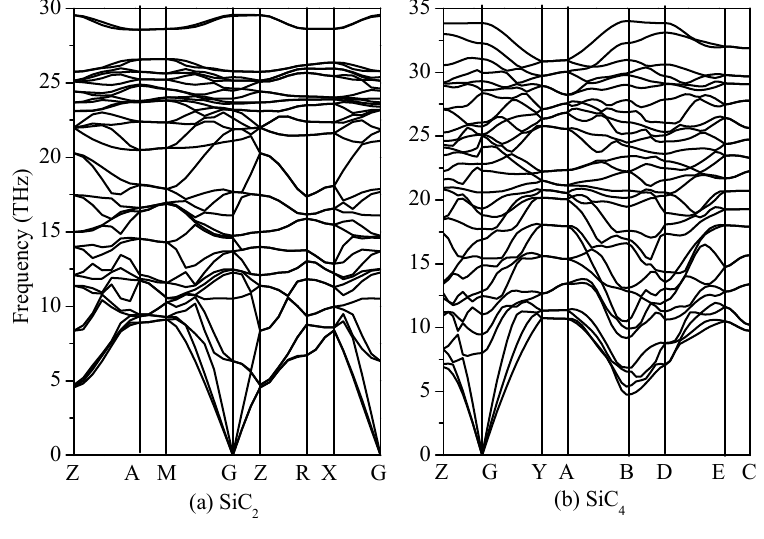
Figure 3. Phonon spectra for SiC 2 ( a ) and SiC 4 ( b ). Table 1. The calculated lattice parameters and elastic moduli of SiC 2 , SiC 4 , and 3C-SiC. (Space group: SG).